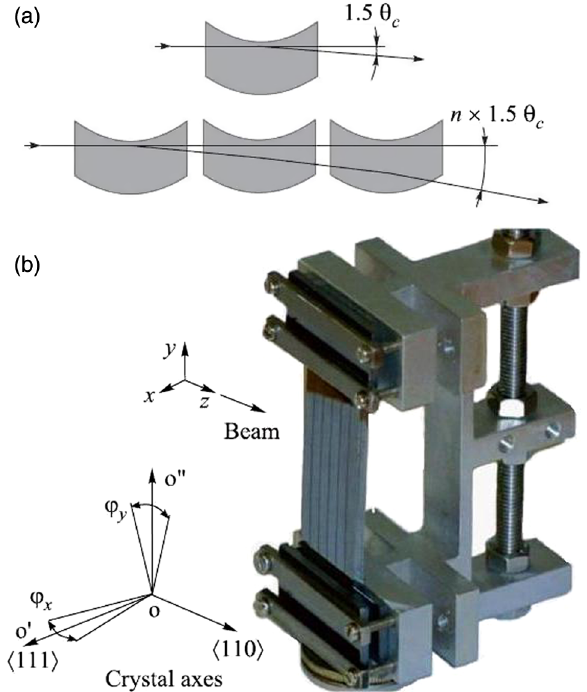
FIG. 1. Multilayer crystal radiator for the beam: ( а ) the schematic of operation and (b) the appearance and arrangement with respect to the